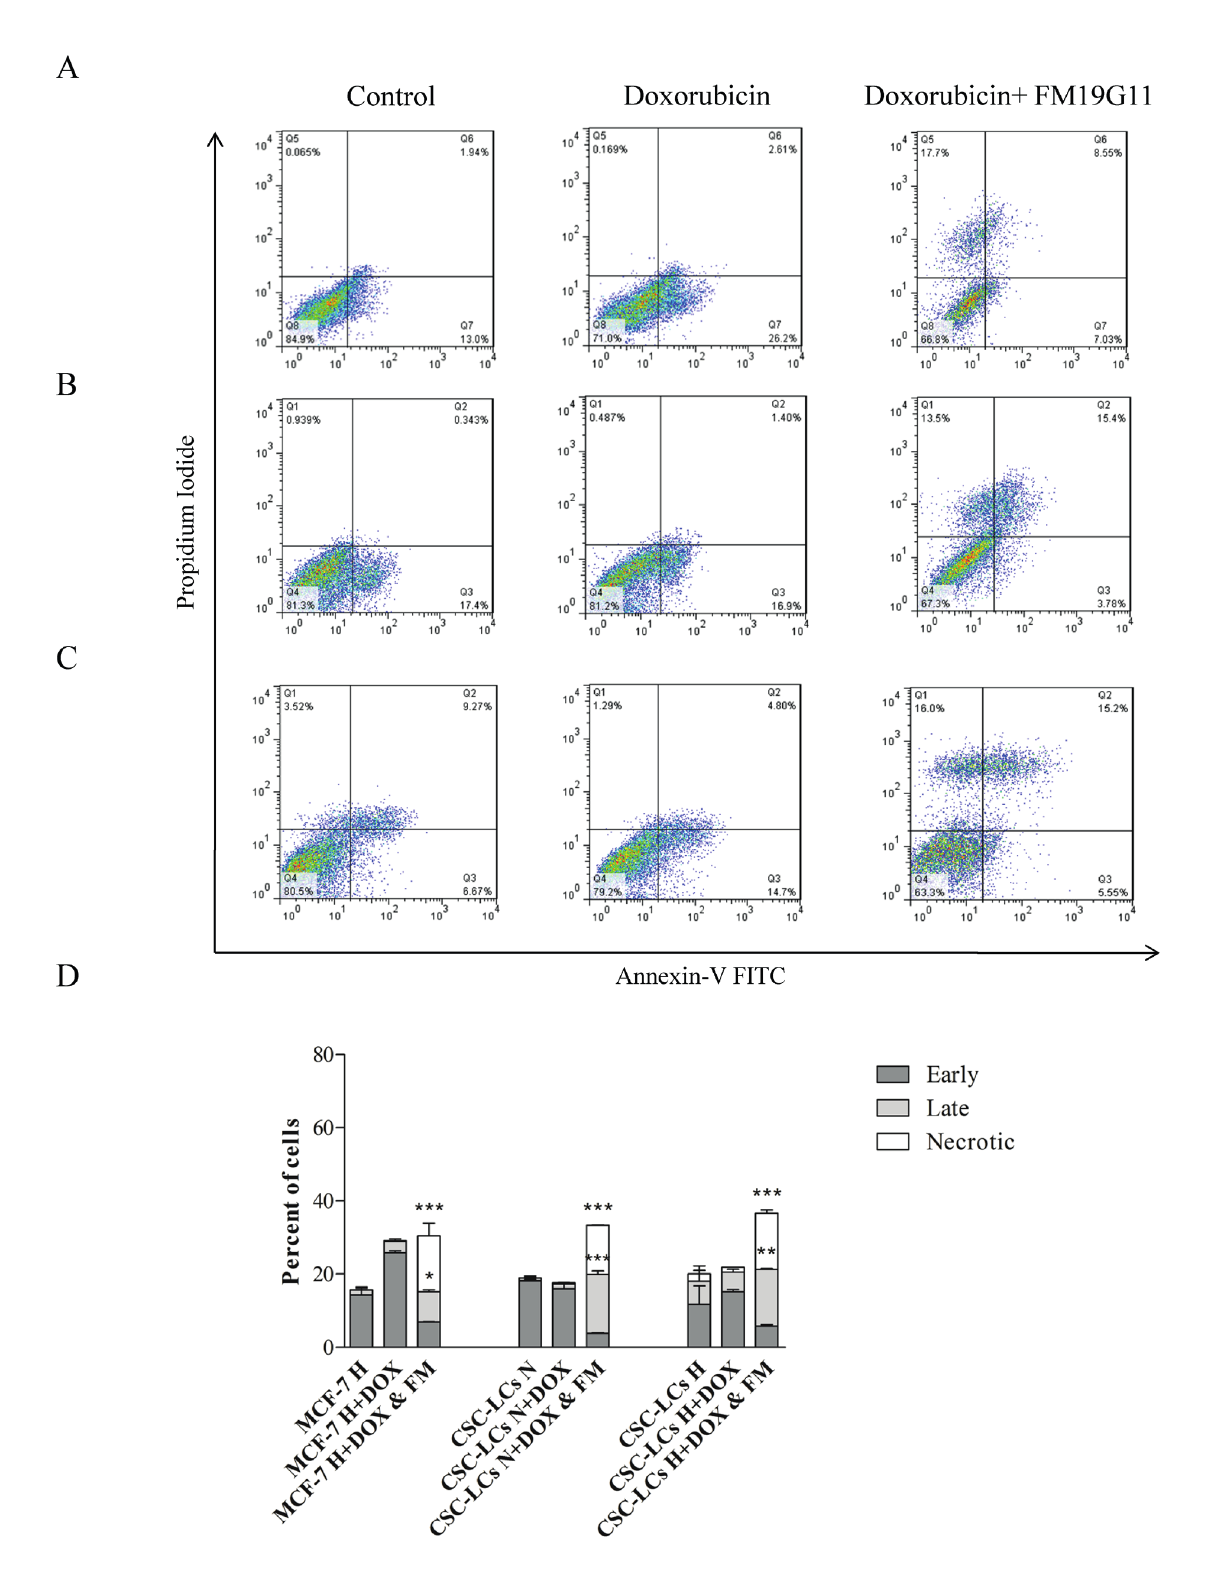
FIGURE 3 - Combination treatment with doxorubicin (DOX) and FM19G11 (FM) resulted in apoptotic and necrotic cell death in MCF-7 and their CSC-LCs in hypoxic (H) and normoxic (N) conditions. (A) MCF-7 cells in hypoxic condition; (B) CSC-LCs in normoxic condition; (C) CSC-LCs in hypoxic condition; (D) Percentage of cells that underwent apoptosis and necrosis. * P < 0.05, ** P < 0.01, and *** P < 0.001 as compared to control